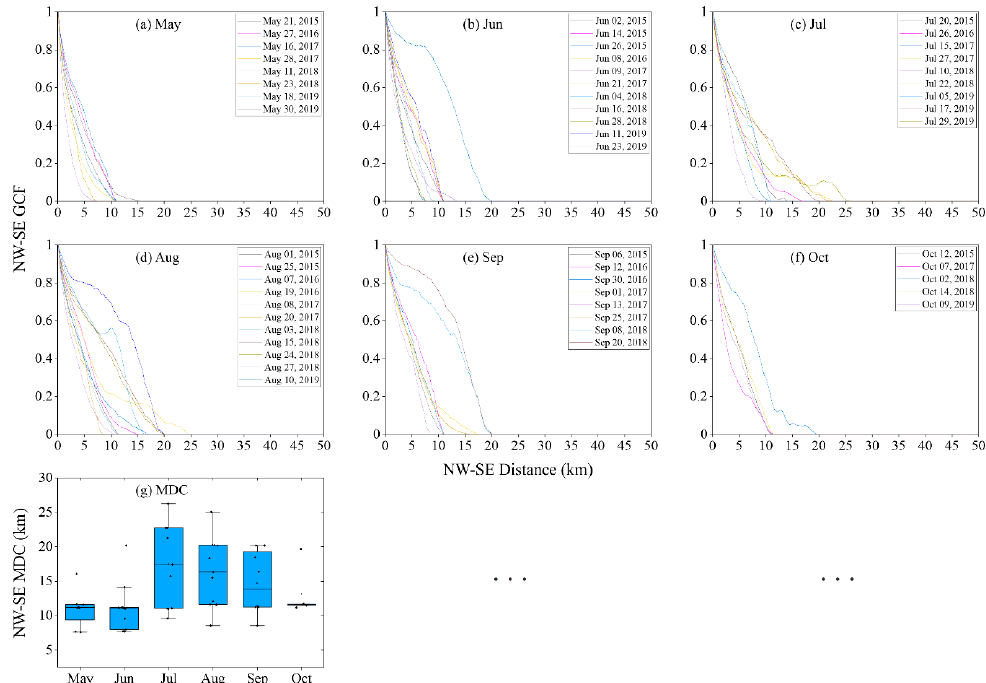
Figure 6. Changes in geospatial connectivity function (GCF) and maximum distance of connection (MDC) in the N–S direction of the Momoge National Nature Reserve, China from 2015 to 2019. ( a – f ) indicate May to October and ( g ) indicates MDC.